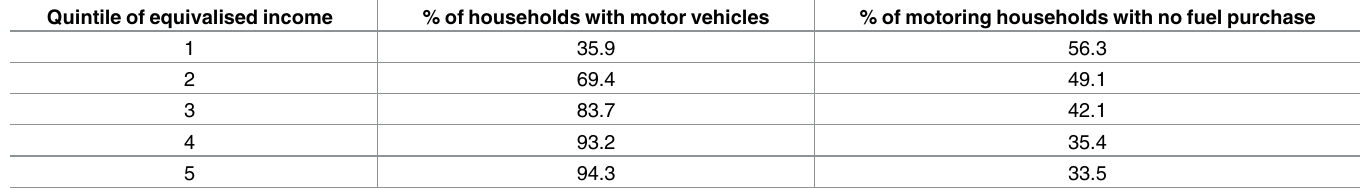
Table 1. Extent of infrequency of purchase by income